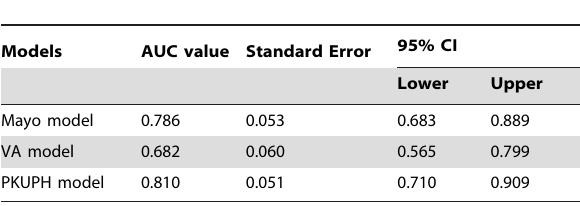
Table 5. Comparison of different models on AUC value*.